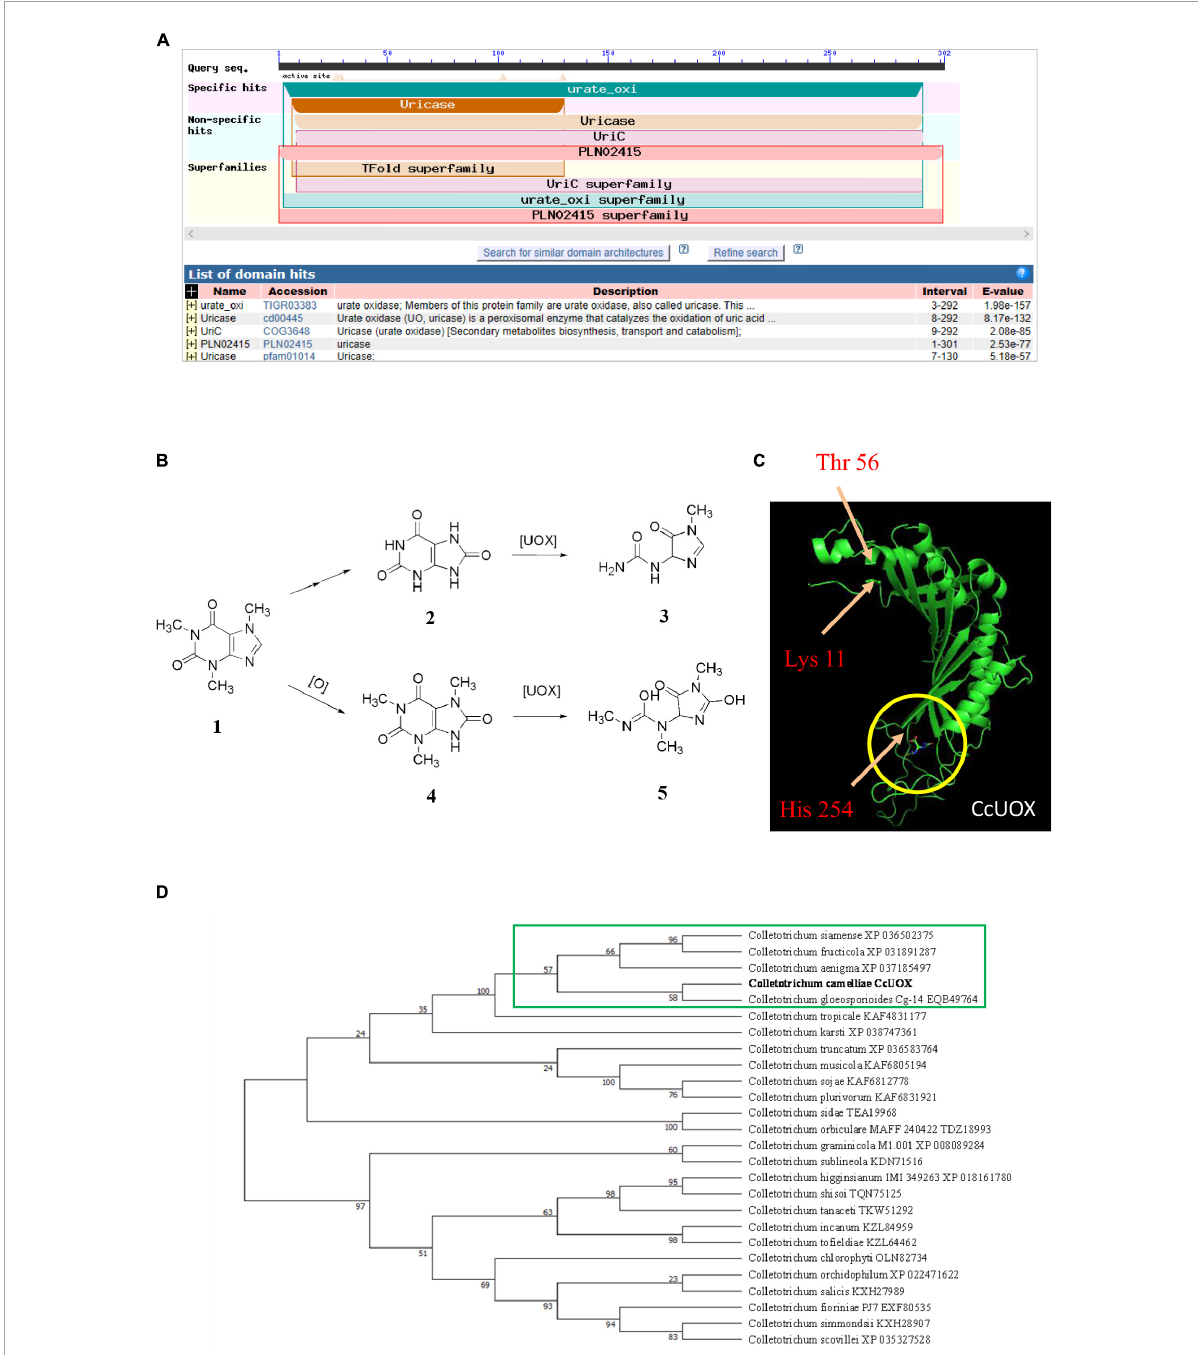
FIGURE4 Characteristics analysis of CcUOX in C. camelliae. (A) Blast analysis indicates CcUOX protein contained conserved domains of urate oxidase. (B) UOX involved in caffeine metabolism. 1. Caffeine, 2. Uric acid, 3. Allantoin, 4. 1,3,7-trimethyluric acid, 5. 3,6,8-trimethylallantoin. (C) The predicted structures of CcUOX. The arrows indicated the conserved catalytic triad residues. The circles indicated the predicted ligand binding sites. (D) Phylogenetic tree of CcUOX proteins with indicated Colletotrichum species. The indicated proteins including Colletotrichum gloeosporioides Cg-14 (EQB49764), C. siamense (XP 036502375), C. fructicola (XP 031891287), C. aenigma (XP 037185497), C. tropicale (KAF4831177), C. karsti (XP 038747361), C. truncatum (XP 036583764), C. musicola (KAF6805194), C. sojae (KAF6812778), C.